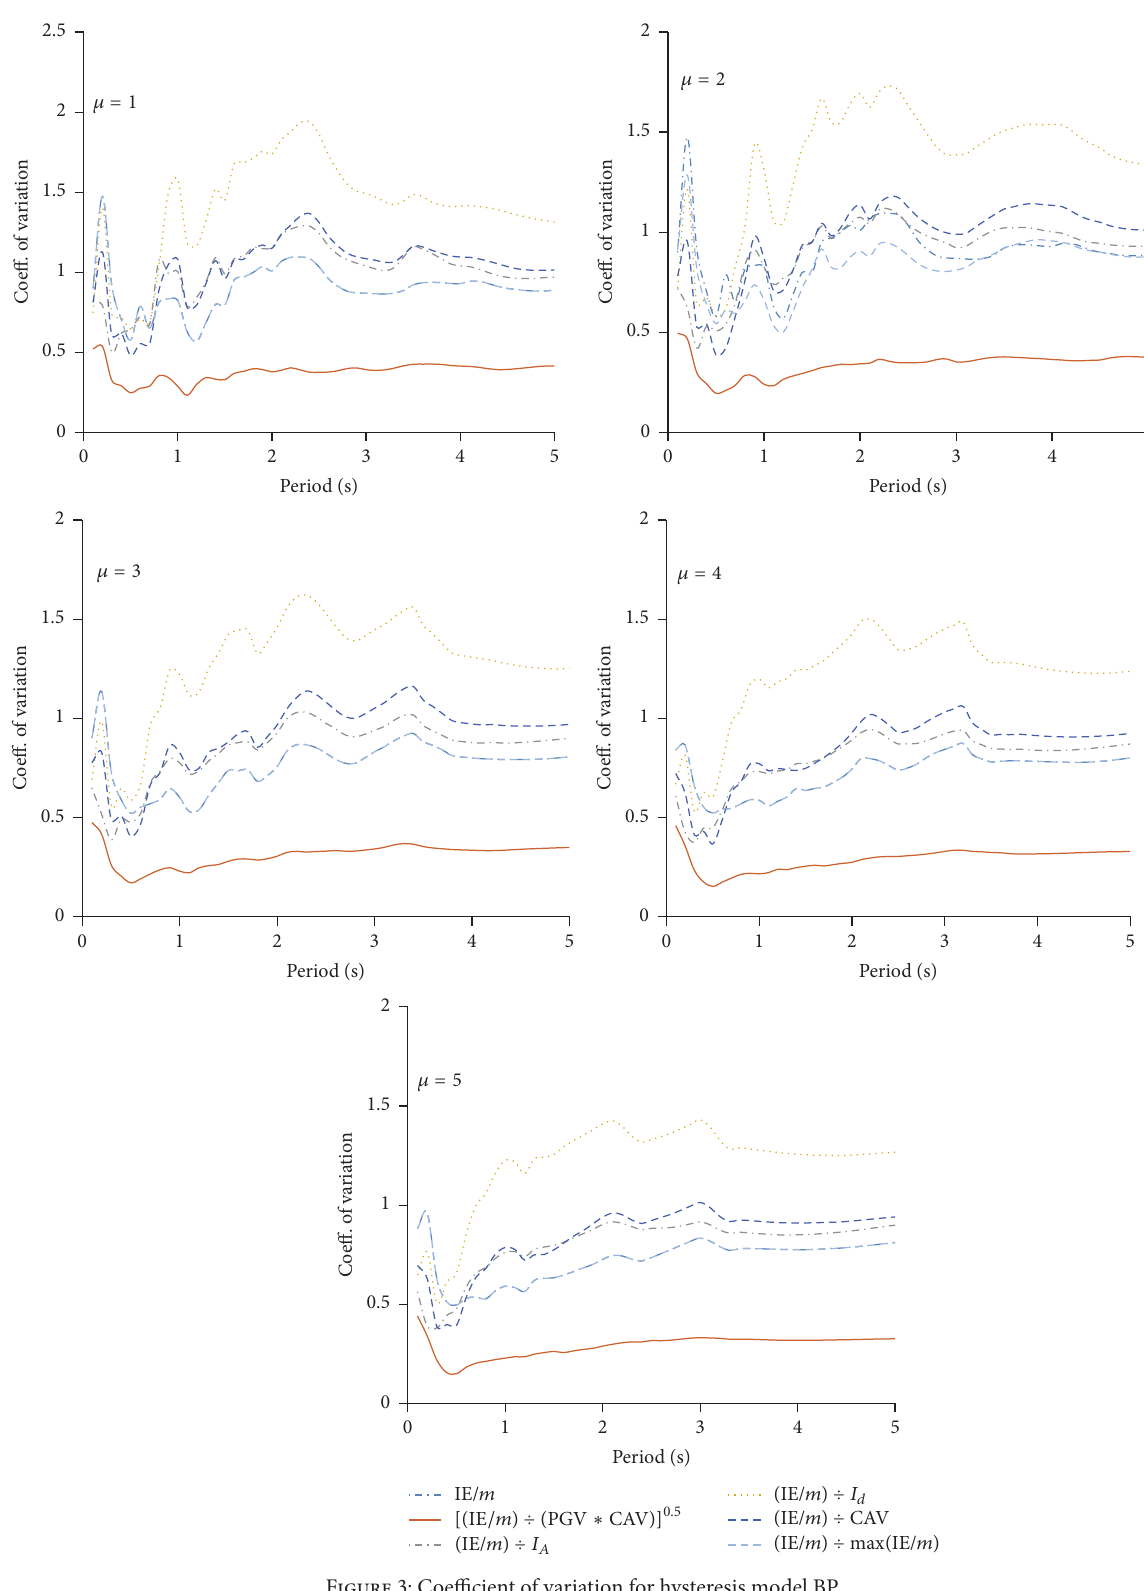
Figure 3: Coefficient of variation for hysteresis model